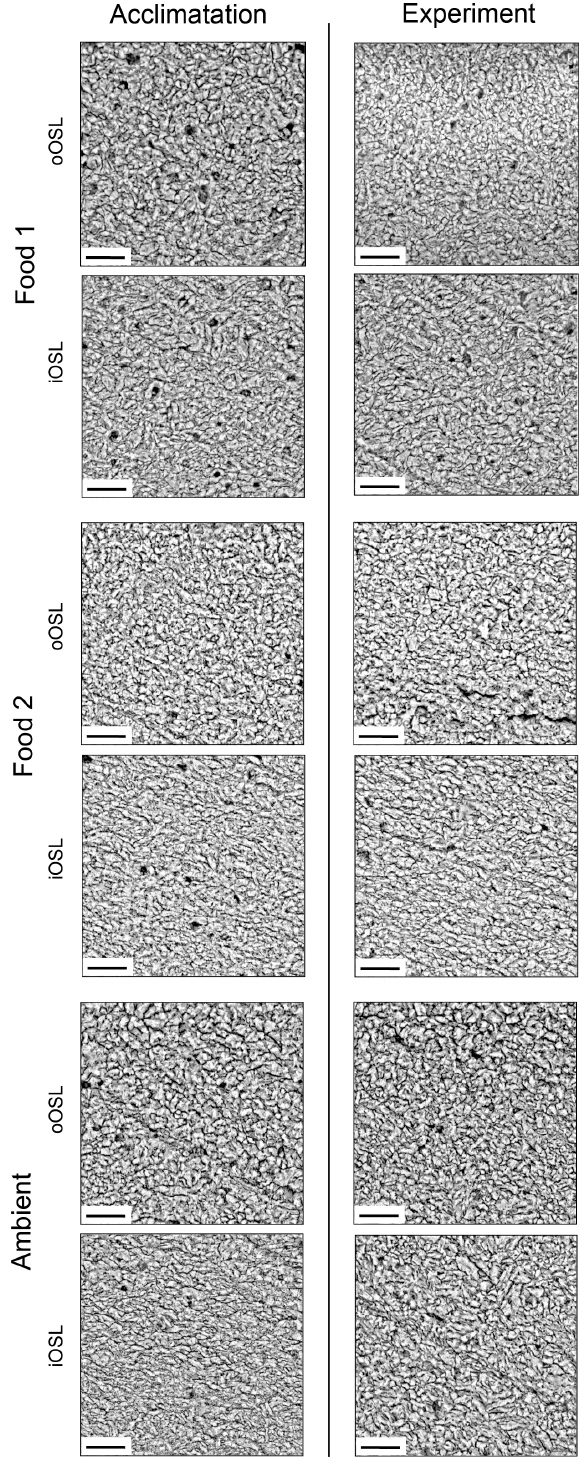
Figure 8. SEM images of Arctica islandica shell microstructures formed during the acclimation phase at AWI (left column) and dur- ing the food experiment (right column). Scale bars =